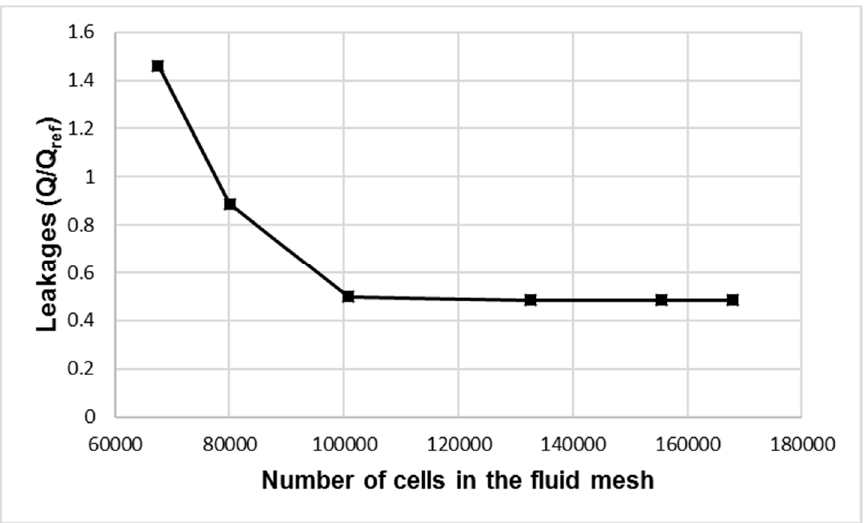
Figure 8. Flowchart representing the numerical scheme implemented in the mixed-TEHD model for the lateral lubricating gaps in EGMs.